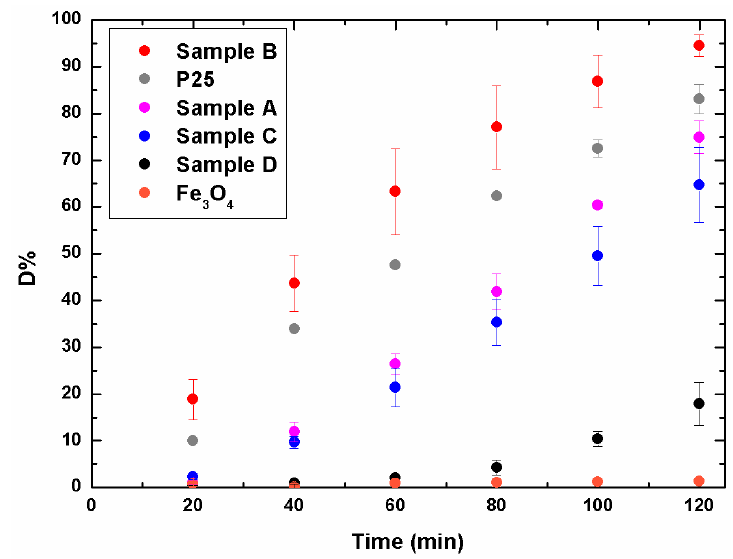
Figure 4. Percent degradation of MB versus time. The experimental points (Table S1) are averaged over three replicates. (Color figure online).